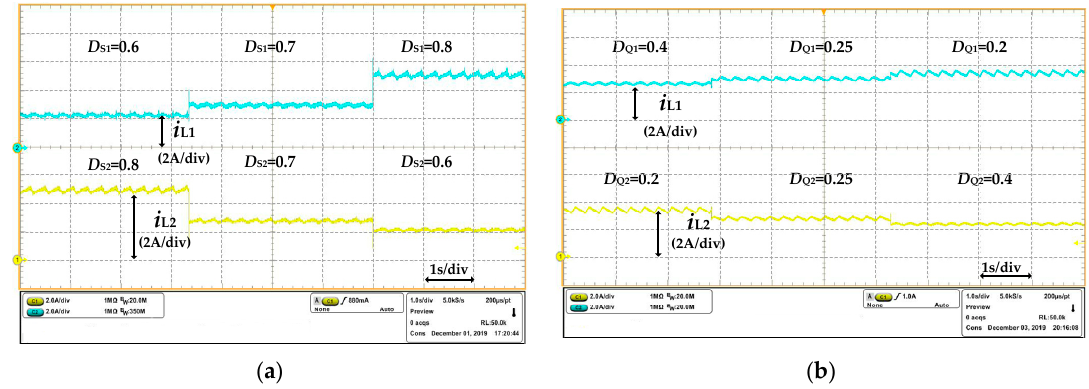
Figure 12. Power flow diagram for ( a ) discharging mode (Boost); ( b ) charging mode (Buck).